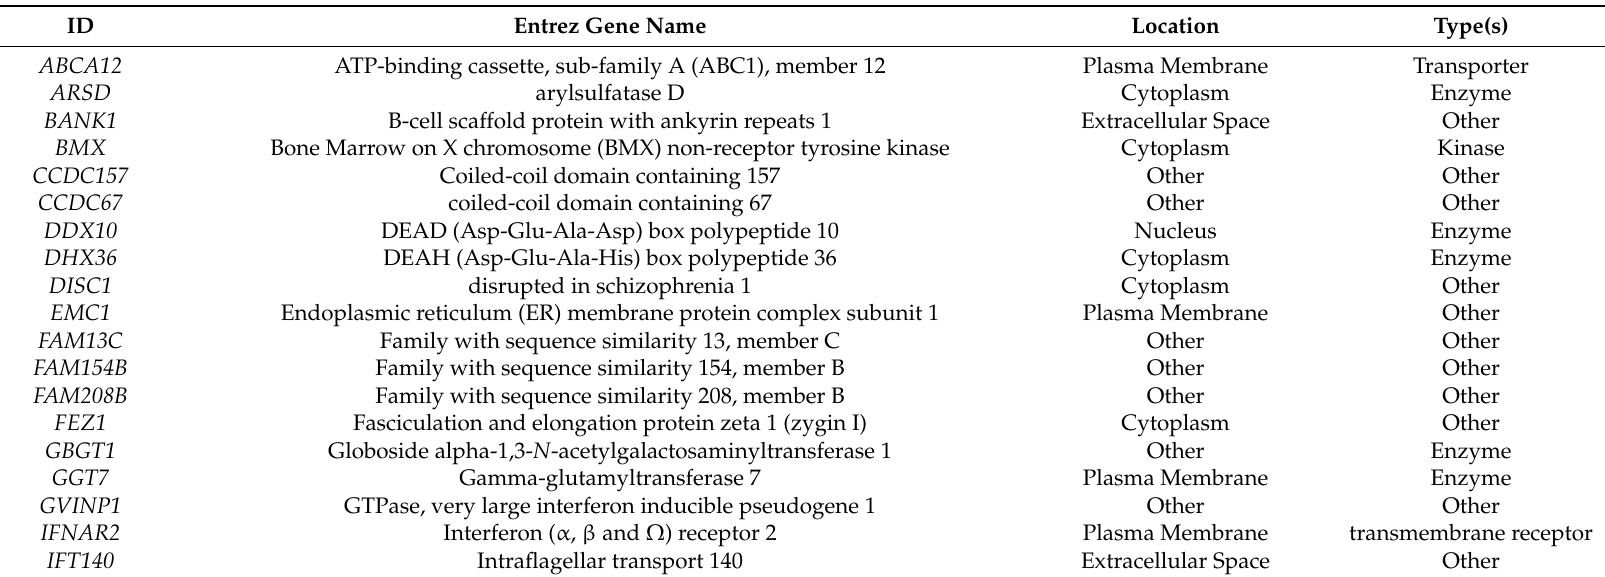
Table 5. Gene name and functions of genes containing amino acid changes showing over 10 depth counts in AR